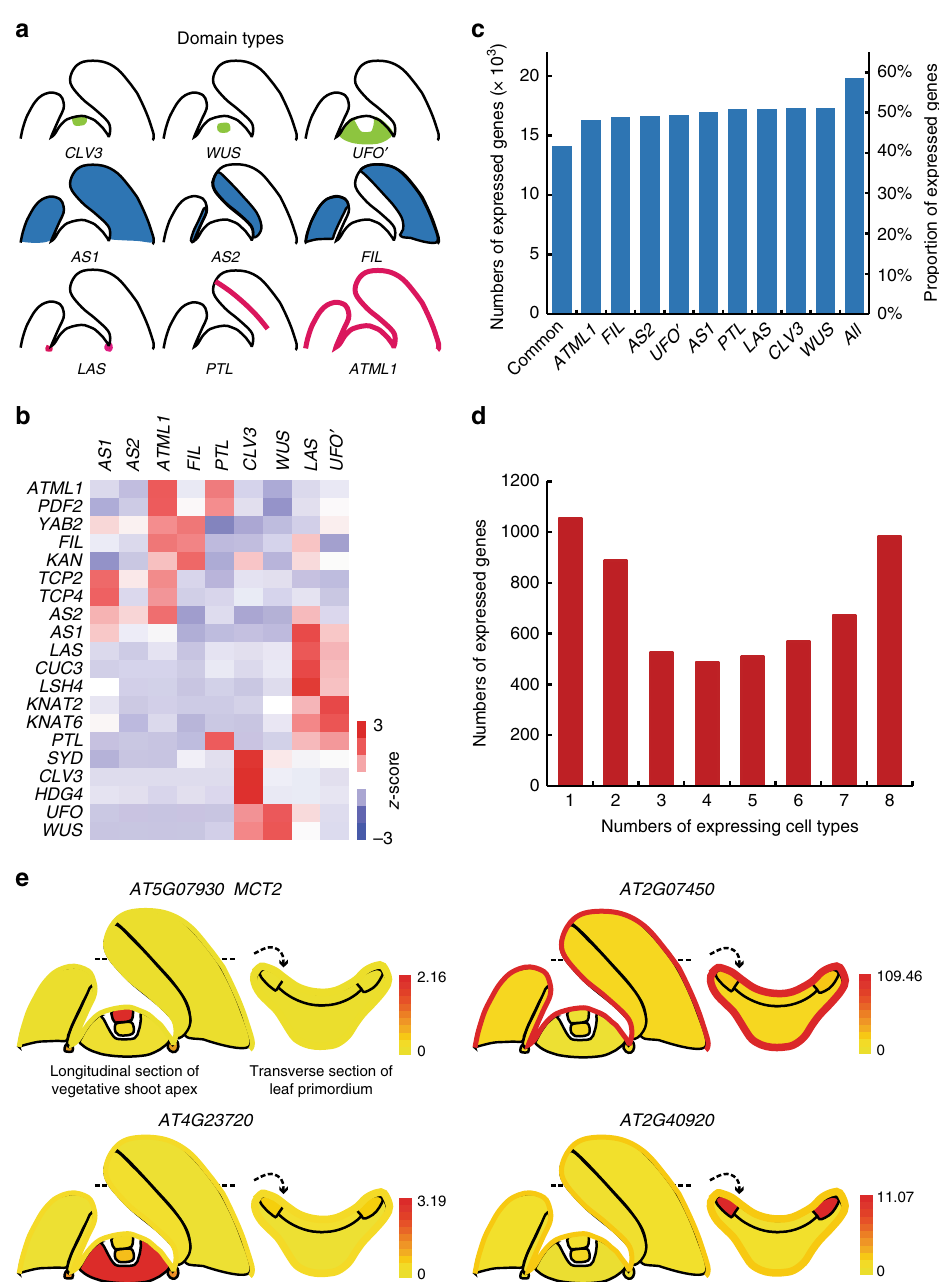
Fig. 1 Properties of cellular gene expression. a Diagrams showing different spatial domains being pro fi led. b Marker gene expression pattern in different cellular transcriptomes. Relative expression ( z -score) is displayed in colors, in which red indicates enrichment and blue indicates depletion as shown. Labels on the top show domains. The gene names are shown on the left. c Numbers and proportion of expressed genes in each domain. d Numbers of expressed genes in multiple domain groups. e eFP browser view of expression changes in the shoot apex for selected genes. Whereas MEI2 C-TERMINAL RRM ONLY LIKE 2 ( MCT2, AT5G07930 ) is a previously identi fi ed CZ-speci fi c gene 21 , all others are unknown domain-speci fi c genes. Absolute gene expression values were calculated and shown for each